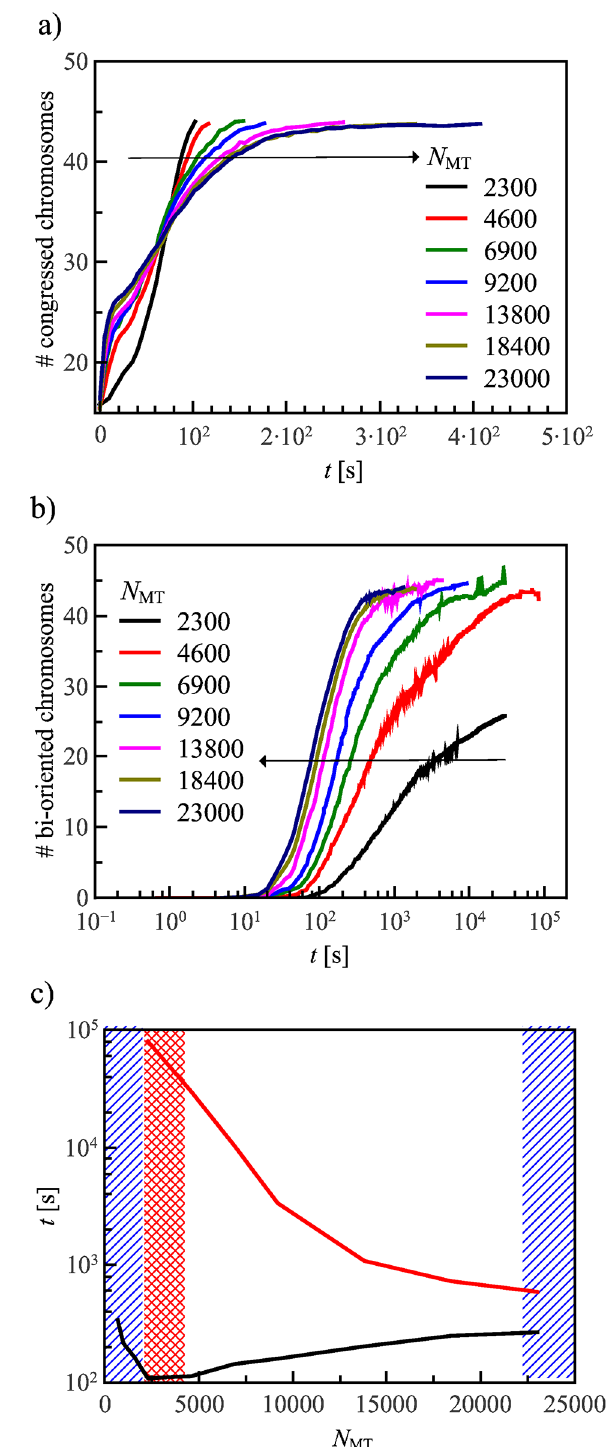
Fig 6. The distribution of (a) congression and (b) bi-orientation times for various MT densities. The arrows indicate the trends for increasing MT densities. Congression is faster for a lower number of MTs per kinetochore, because PEFs are directly proportional to the number of MTs. However, bi-orientation is much slower for low MT densities, because the time needed to find every kinetochore is strongly influenced by the number of MTs. This is summarized in (c) showing the time t p = 1/2 for which the